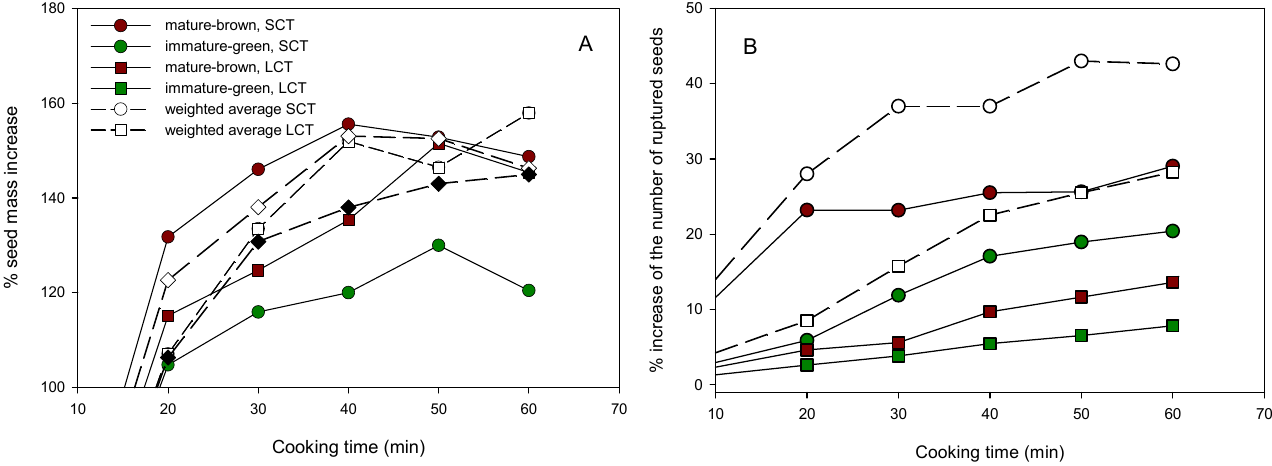
Figure 1. Percentage of mass increase ( A ) and increase in the number of overcooked seeds ( B ) of MB